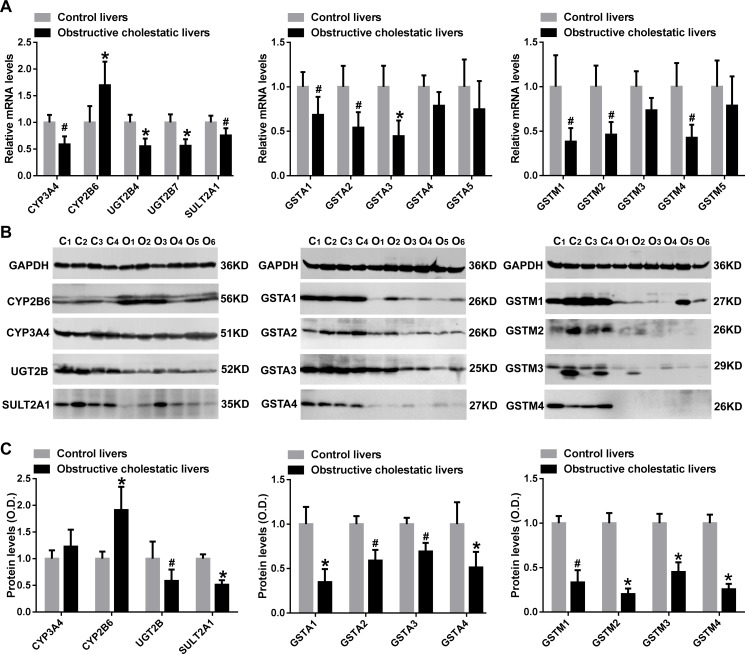
The levels of detoxification enzymes in liver samples of patients with obstructive cholestasis.A) Real-time qPCR analysis of detoxification enzymes CYP2B6, CYP3A4, UGT2B4, UGT2B7, SULT2A1, GSTA1-A5 and GSTM1-M5 mRNA levels in cholestatic livers and controls of patients. B) Representative western blots for CYP2B6, CYP3A4, UGT2B, SULT2A1, GSTA1-GSTA4 and GSTM1-GSTM4 protein levels in liver samples of patients with obstructive cholestasis and (C) corresponding densitometry (% of control group, n = 22 for each group). *: p < 0.01 and #: p < 0.05 versus controls. C, controls, O, obstructive cholestasis liver samples.